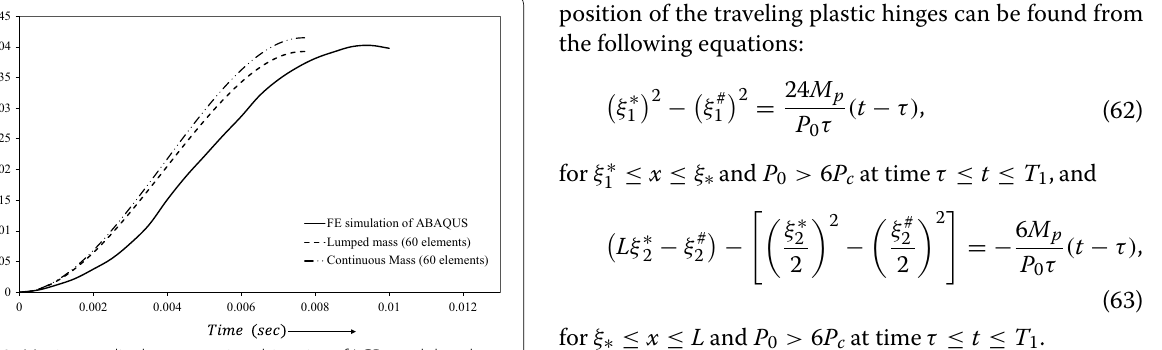
Fig. 22 Maximum displacement time histories of LCP model and